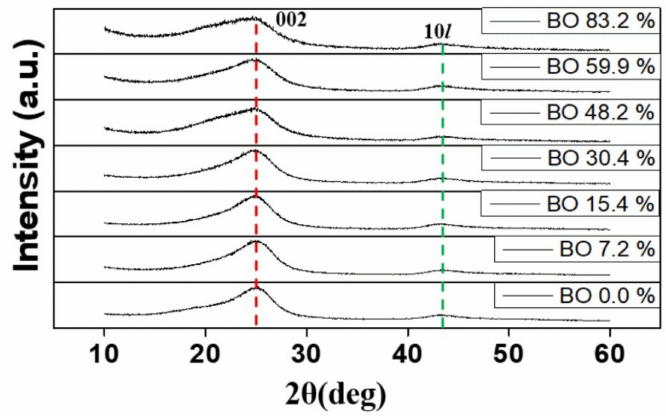
Figure 2. XRD patterns of activated carbon blacks according to burn-off (BO).